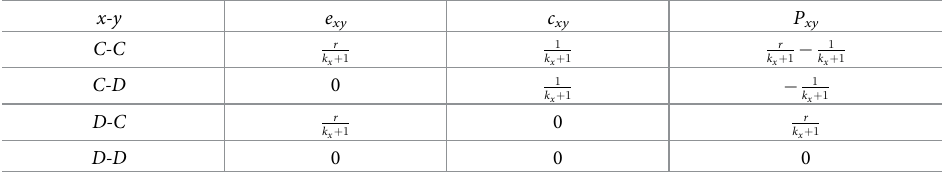
Table 1. Unilateral static payoff analysis of a central player in a separate game. x-y e xy c xy 1 (cid:0) 1 k x þ 1 k x þ 1 0 r D-C r k x þ 1 k x þ 1 D-D 0 0 0 Where x is the central player, y is a neighbor of x and k is the degree of the central player. The strategy chosen by x x and y is denoted by C (Cooperation) or D (Defection). In the table, when x and y choose different strategies in the game, the unilateral payoff of x in edge x-y will be shown. Note that this is after one round of